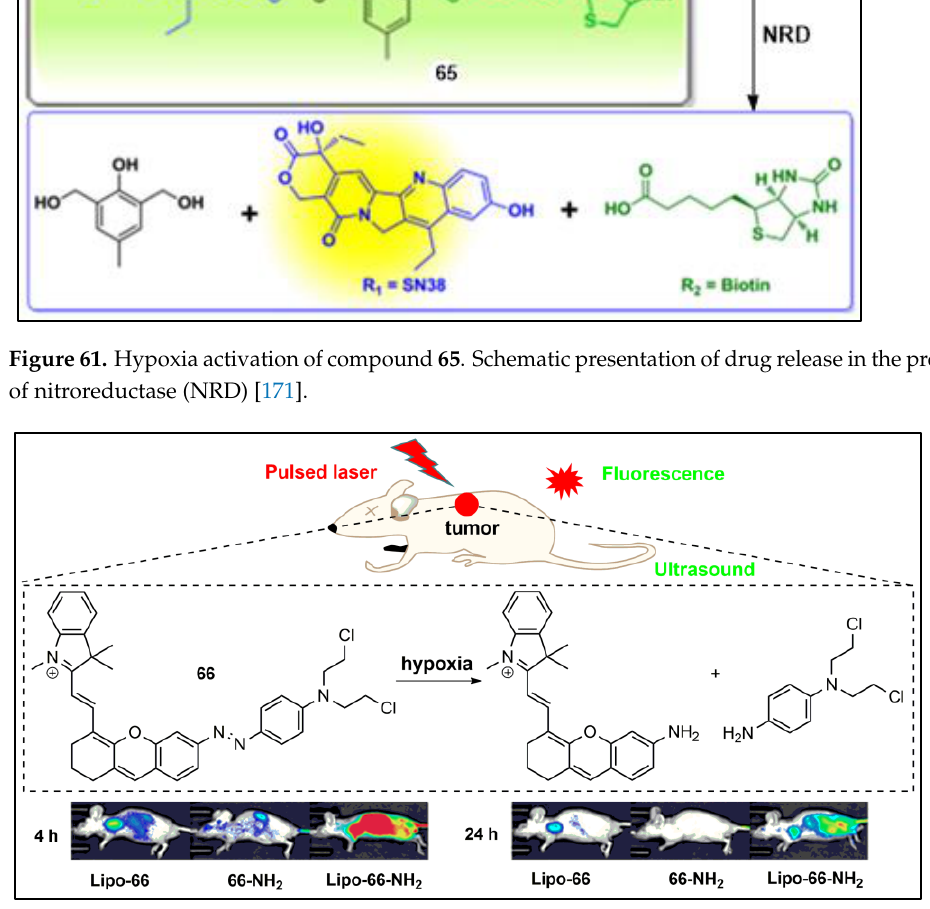
Figure 61. Hypoxia activation of compound 65 . Schematic presentation of drug release in the pres- ence of nitroreductase (NRD) [171].